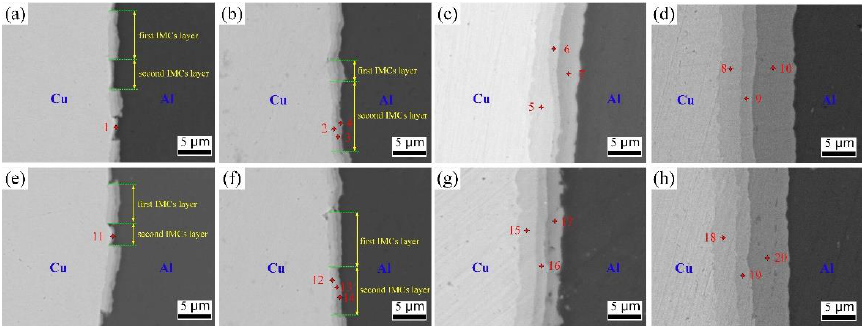
Figure 4. Interface SEM images with different annealing temperature: ( a , e ) 300 ◦ C, ( b , f ) 350 ◦ C, ( c , g ) 400 ◦ C, ( d , h ) 450 ◦ C; ( a – d ) peak, ( e – h ) trough, annealing time: 60 min. Table 3. The element contents of Cu and Al by element point scanning at point 1 – 20 (wt%).